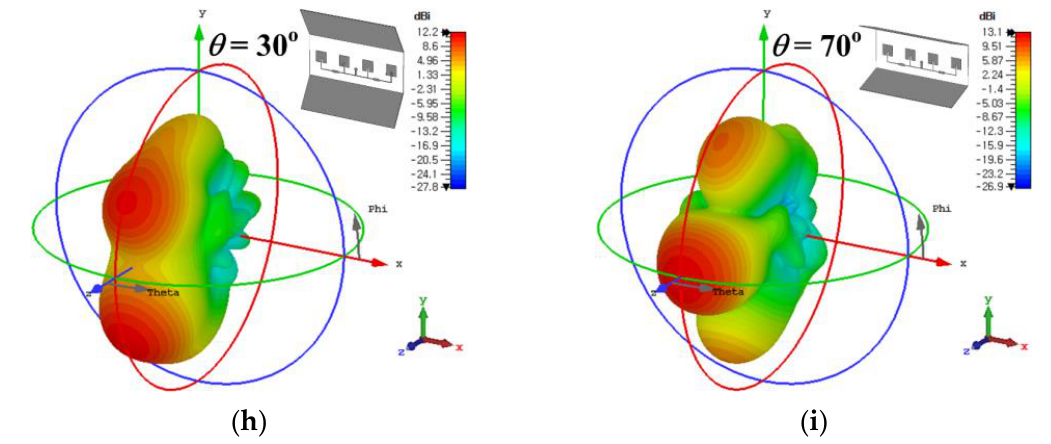
Figure 7. Effects from tilting angle θ of the 4 × 1 array antenna appended with two metallic plates when l m = 10 mm: ( a ) the geometry, ( b ) S 11 , ( c ) the frequencies and magnitudes at the minimum of S 11 , ( d ) realized gain, ( e ) the frequencies and values of maximum gain, ( f ) radiation patterns on the y–z plane for maximum gain frequency, ( g ) radiation patterns on the z–x plane for maximum gain frequency, ( h ) 3D radiation pattern at θ = 30 ° , and ( i ) 3D radiation pattern at θ = 70 ° .